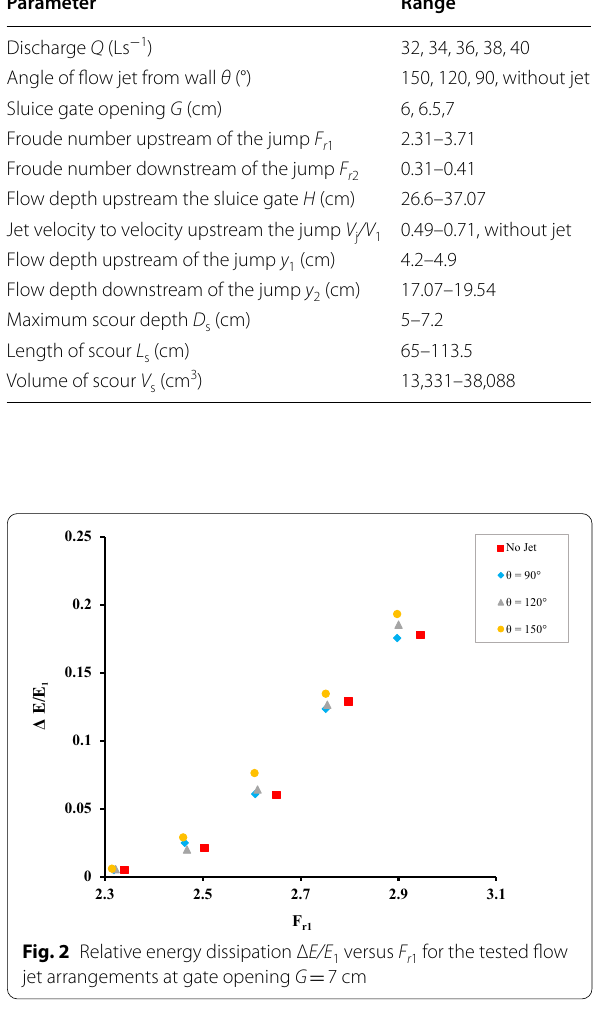
Table 1 Overview of the test conditions and parameter ranges Parameter